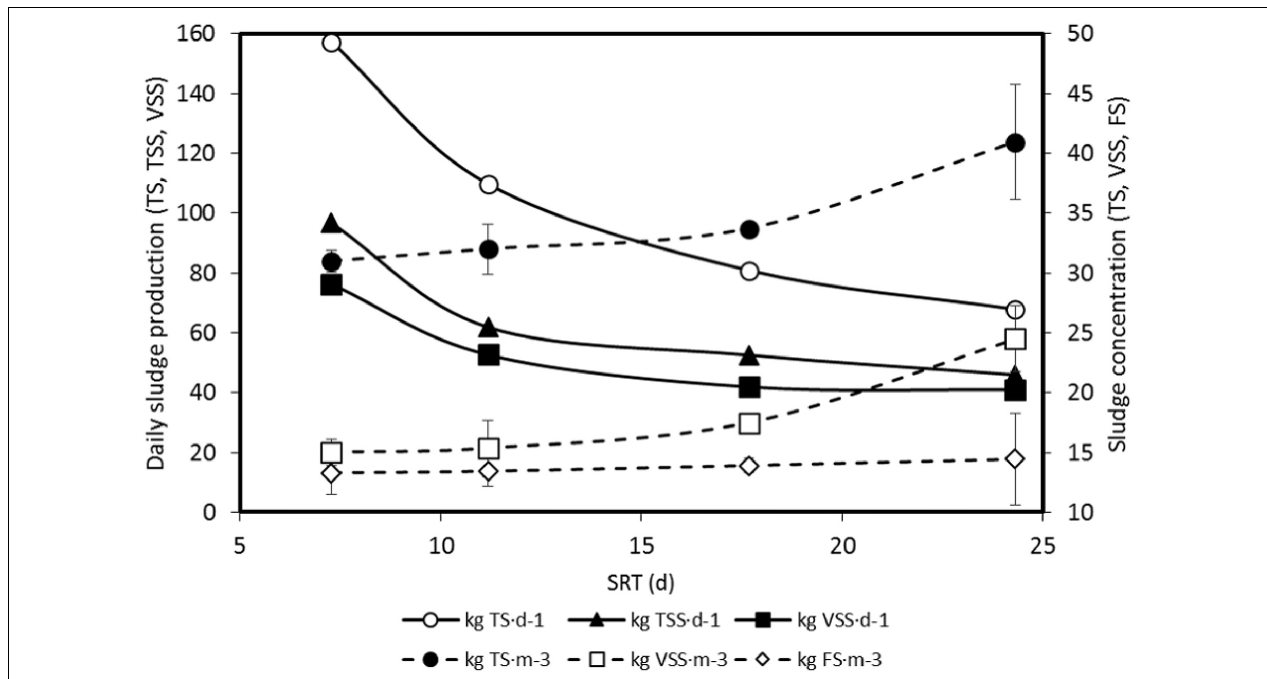
FIGURE 5 | Average daily sludge production in terms of total solids (TS), total suspended solids (TSS), and volatile suspended solids (VSS) and average concentration in the reactor, and in the wasted sludge, of TS, VSS, and fixed solids (FS) for the solids retention time (SRT) values tested. Error bars indicate standard